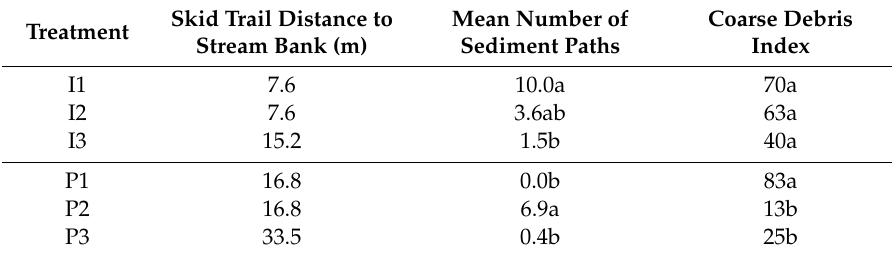
Table 3. Mean number of sediment paths and coarse logging debris index by stream type and SMZ treatment variants. Values with the same letter are not significantly di ff erent ( p < 0.05) within each stream